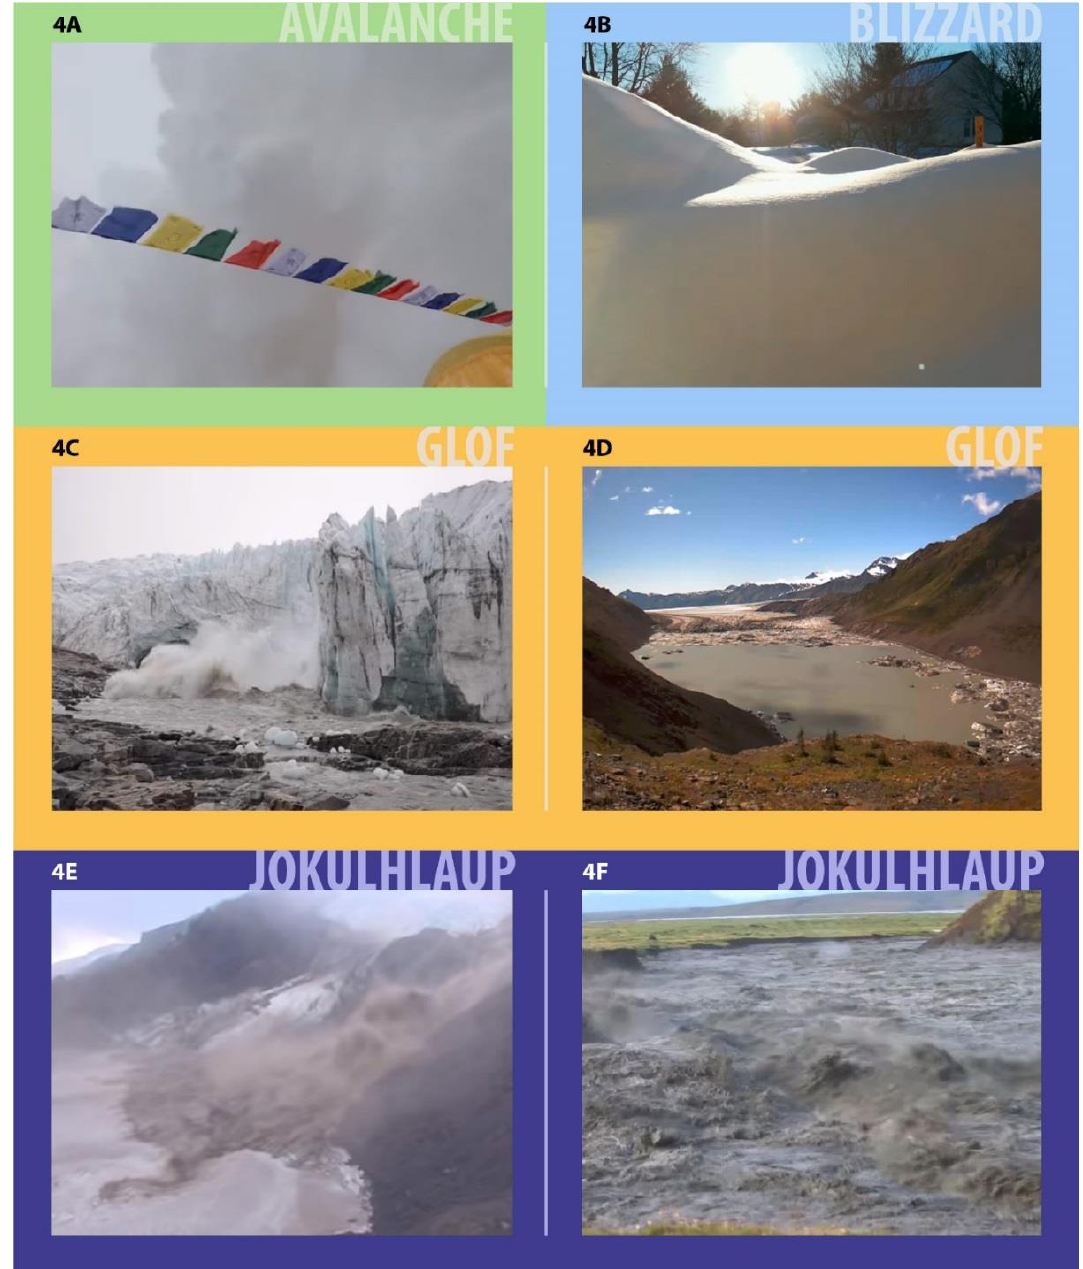
Figure 4. Printscreens from videos capturing selected types of cryospheric hazards. Part ( A ) shows the avalanche cloud just a few seconds before hitting the Everest basecamp on 25 April 2015 ( Hit by Avalanche in Everest Basecamp 25.04.2015 by Jost kobusch); part ( B ) shows about 1 m of new snow resulting from a blizzard in the Northern Virginia, 22 – 24 January 2016 ( Beautiful 48 h Time-Lapse of 2016 Blizzard uploaded by WorseThanChiggers); part ( C ) shows the water displacement following the glacier calving into the adjacent proglacial lake/meltwater river at Russell Glacier, West Greenland (Source: Russell Glacier Lake bursts by WOGACGreenland); part ( D ) shows the pre-outburst state of the lake at Bear Glacier, Alaska, on 9 August 2018, taken from the time-lapse camera (Source: Bear Glacier Ice-dammed Lake Outburst Flood, August 2018 by Kenai Fjords NPS); part ( E ) shows Eyjafjallajökull jokulhlaup on 14 April 2010, Iceland (Source: Eyjafjallajökull glacial flood (jökulhlaup) 14 April 2010 by hpjons); and part ( F ) shows previously unreported 2015 Skaftárhlaup jokulhlaup on Iceland (Source: Skaftárhlaup_3_BDMV by Pall Jokull Petursson).